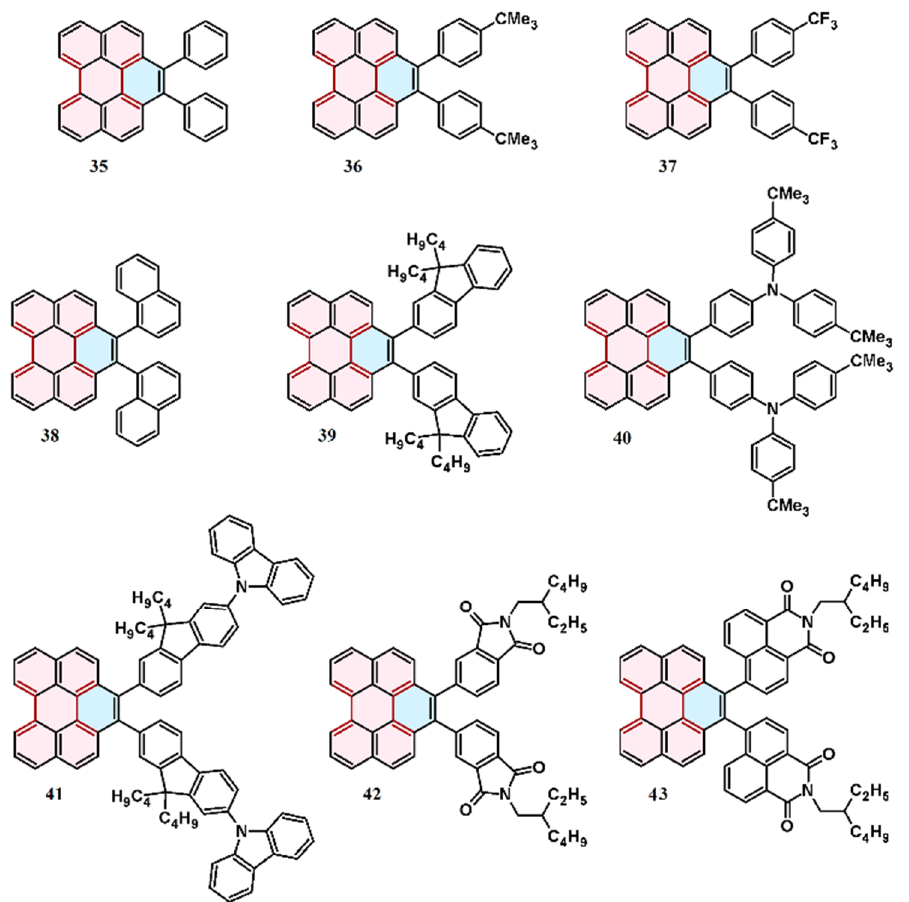
Figure 2. Cycloaddition of 1,2-diarylacetylenes to the perylene bay region: list of obtained products. Y = 45% ( 35 ), 18% ( 36 ), 27% ( 37 ), 7% ( 38 ), 50% ( 39 ), 21% ( 40 ), 33% ( 41 ), 42% ( 42 ), and 10% ( 43 ).